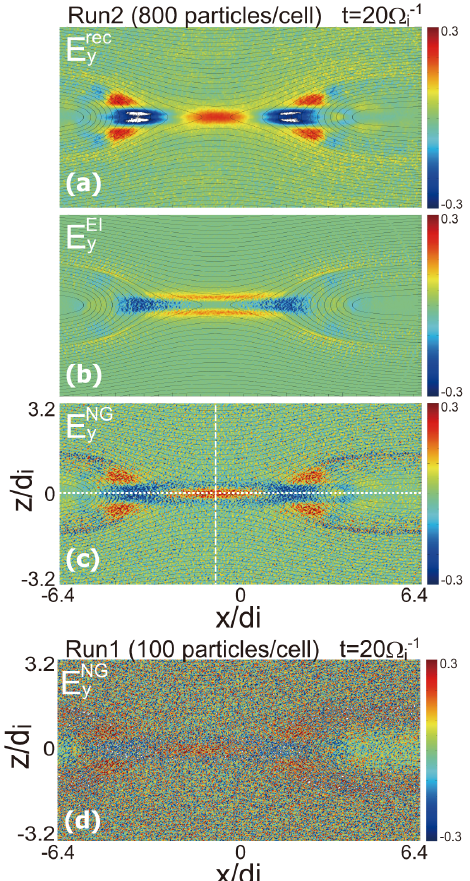
Figure 2. Color contours of (a–c) E rec y = ( E + U e × B ) y , E EI y